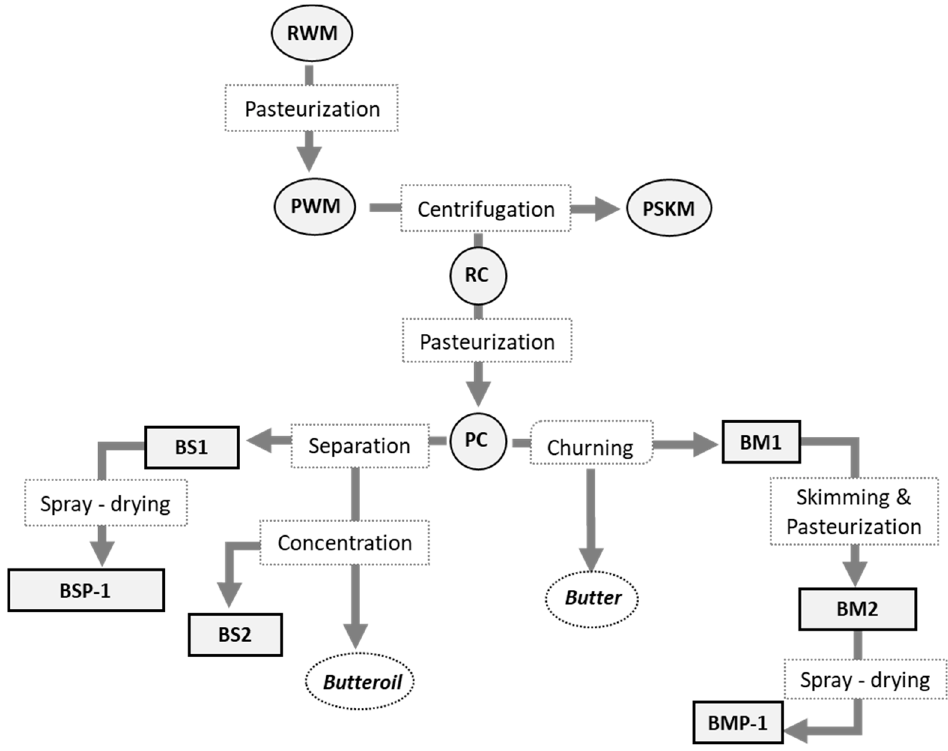
Figure 1. Flowchart of the studied samples obtained from butter and butter oil processing. At least two replicates of each type of sample were studied.